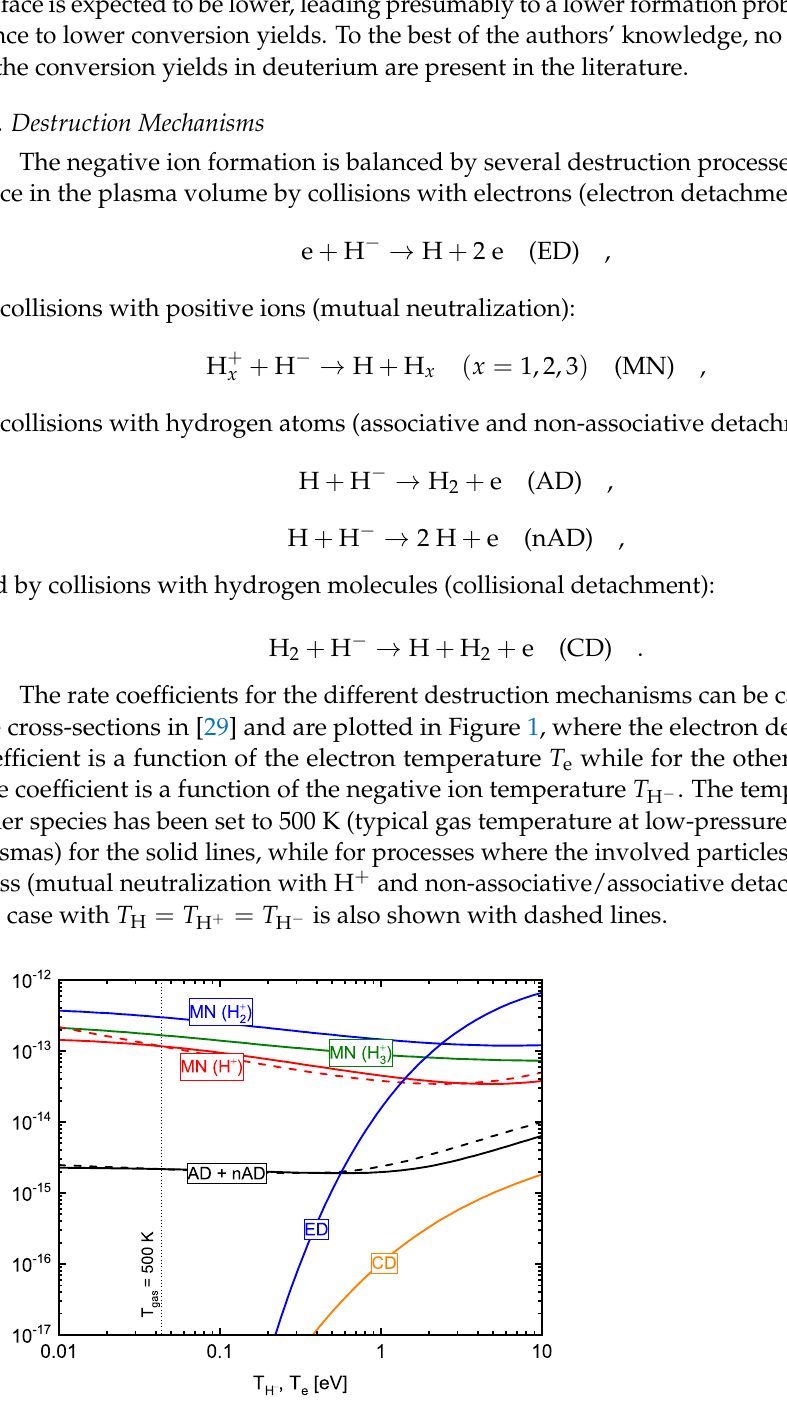
Figure 1. Rate coefficients of the different H − destruction processes, calculated from the cross sections in [29] as functions of the electron temperature for the electron detachment process and of the H − temperature for the other processes. Solid lines correspond to fixed temperatures for neutral particles and positive ions of 500 K, while the dashed lines correspond to T H = T H + = T H −